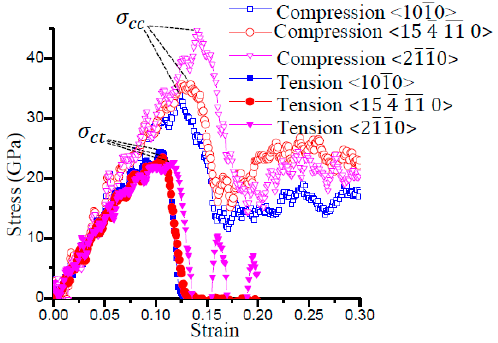
Figure 5. Stress-strain curves from MD simulations.